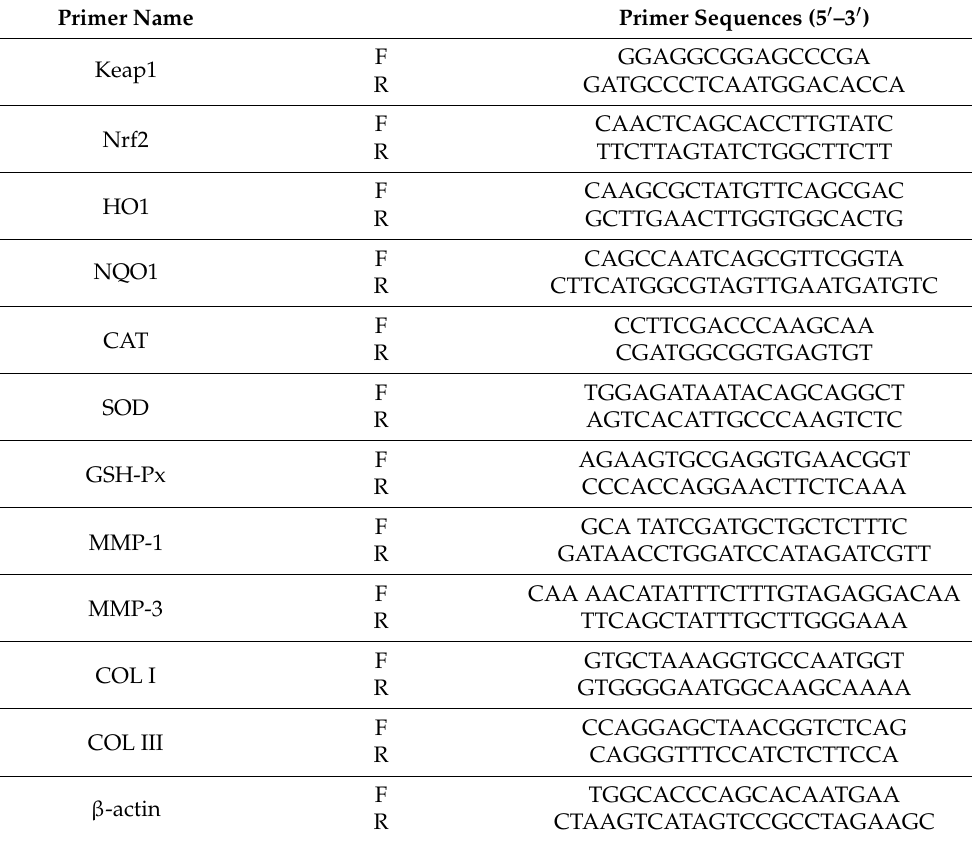
Table 2. The primer sequences of key